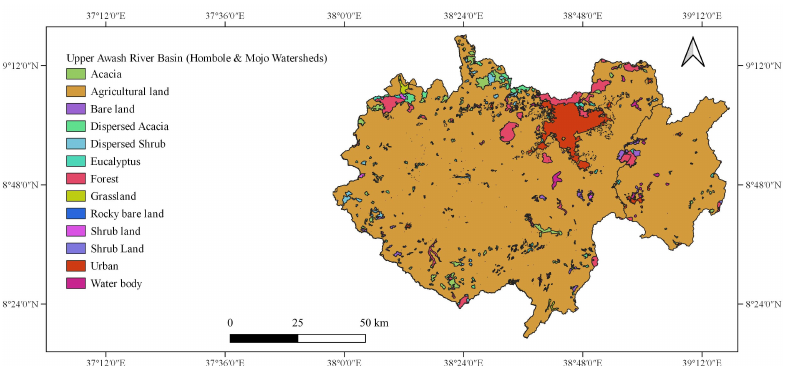
Figure A5. Land use map of Upper Awash River Basin (Hombole and Mojo watersheds) from 2001 to